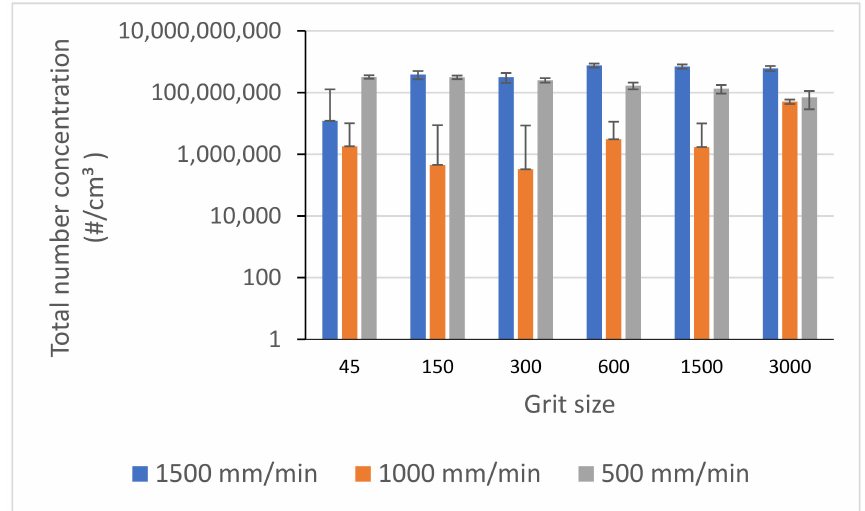
Figure 17. Total number concentration of UFP while grinding black granite for different feed rates (Vs = 2500